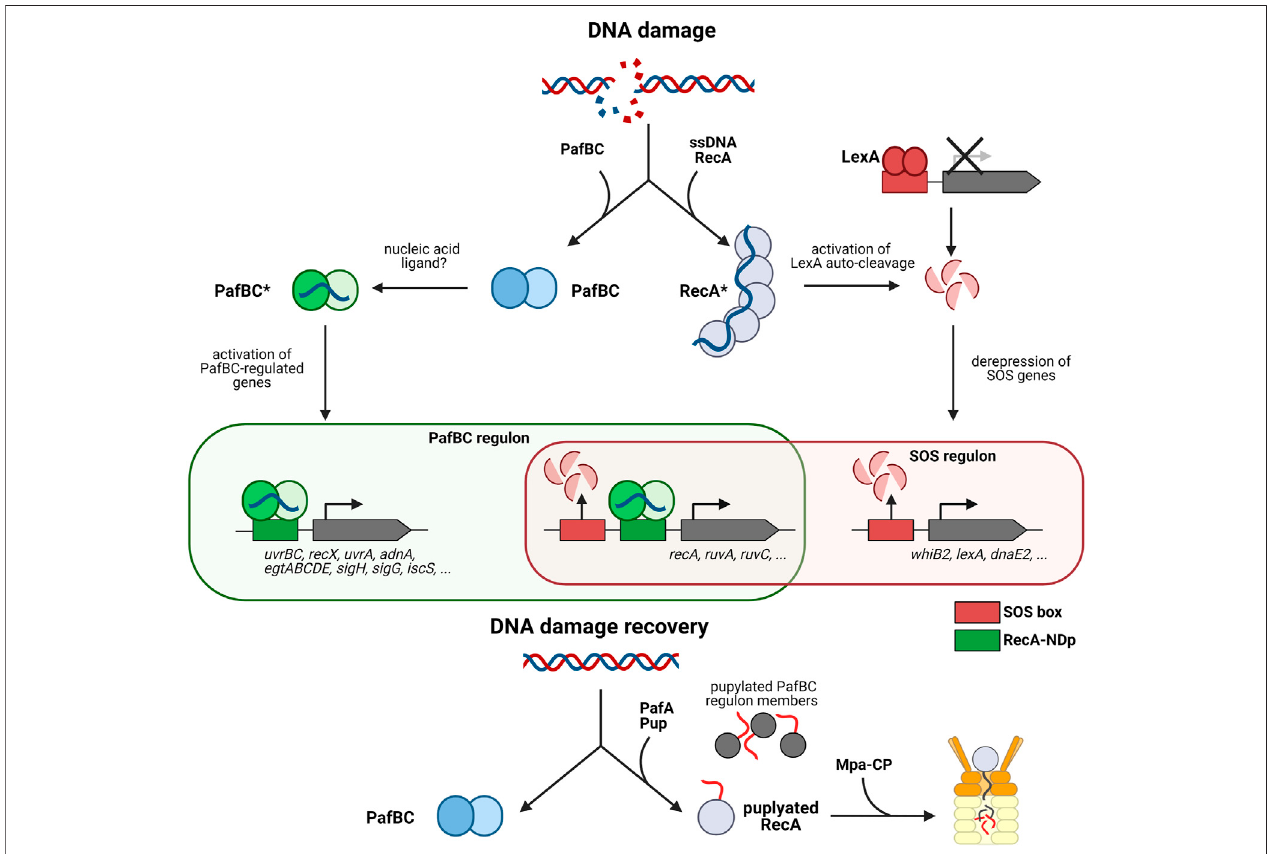
FIGURE3| ThepupylationlocusininvolvedinthemycobacterialDNAdamageresponse.ThemycobacterialDNAdamageresponseismediatedbytwopathways, the SOS response mediated by repressor LexA and the response mediated by activator PafBC. The canonical SOS response pathway is illustrated on the right (LexA/ RecA-dependentpathway).UponDNAdamageRecAforms fi lamentsonssDNA,whichstimulatesauto-cleavageoftherepressorLexA.LexAdissociatesfromtheSOS box which in turn, upregulates transcription of DNA damage response genes such as recA . The left side shows the PafBC-dependent DNA damage response pathway. Upon binding of a response-producing ligand (hypothesized to be a nucleic acid) PafBC is activated and binds to the RecA-NDp promoter, activating the transcription of many genes involved in DNA repair and oxidative stress response. Upon return to normal conditions, RecA along with several other PafBC regulon members(EgtD,TopoN,IscS,RuvA,etc.)arepupylatedandremovedbythePup-proteasomesystemtorecoverfullyfromDNAdamage.Interestingly,somegenessuch as recA , uvrA , and uvrC are regulated by the PafBC regulon as well as the SOS